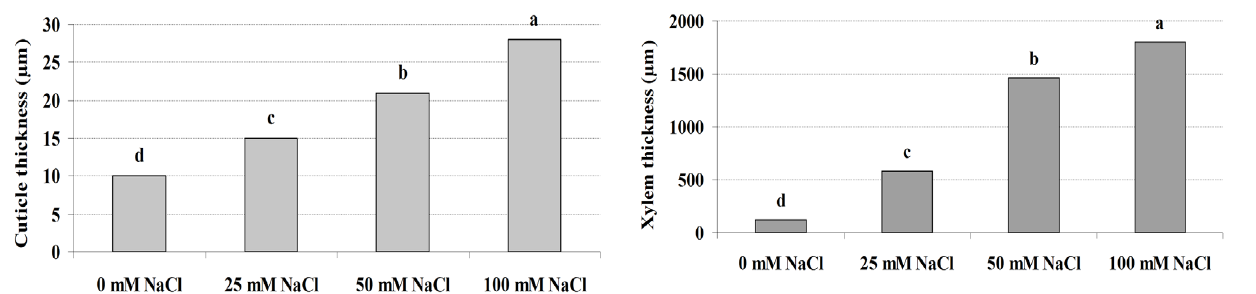
Fig. 2. Changes in stem cuticle thickness affected by different salinity stress. Within each column followed by the same letter are not significantly differences (p < 0.05)